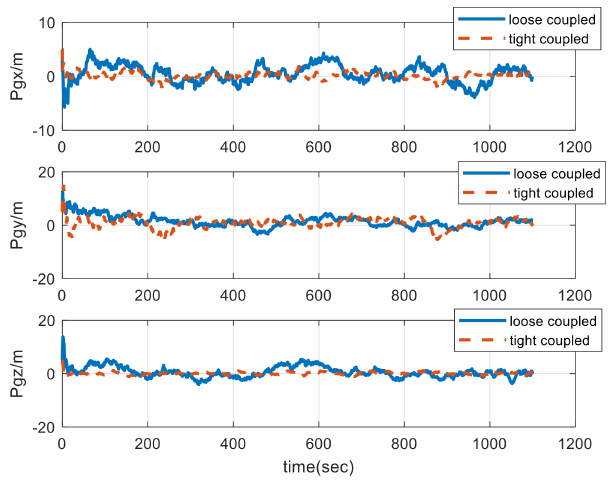
Figure 7. Comparison of position errors between loose and tight